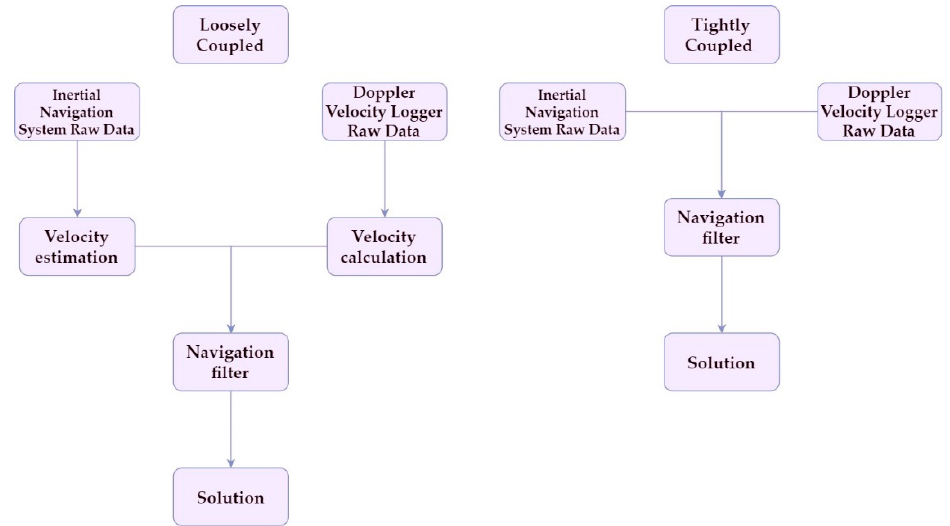
Figure 13. Loosely Coupled (LC) vs. Tightly Coupled (TC) sensor fusion schemes.